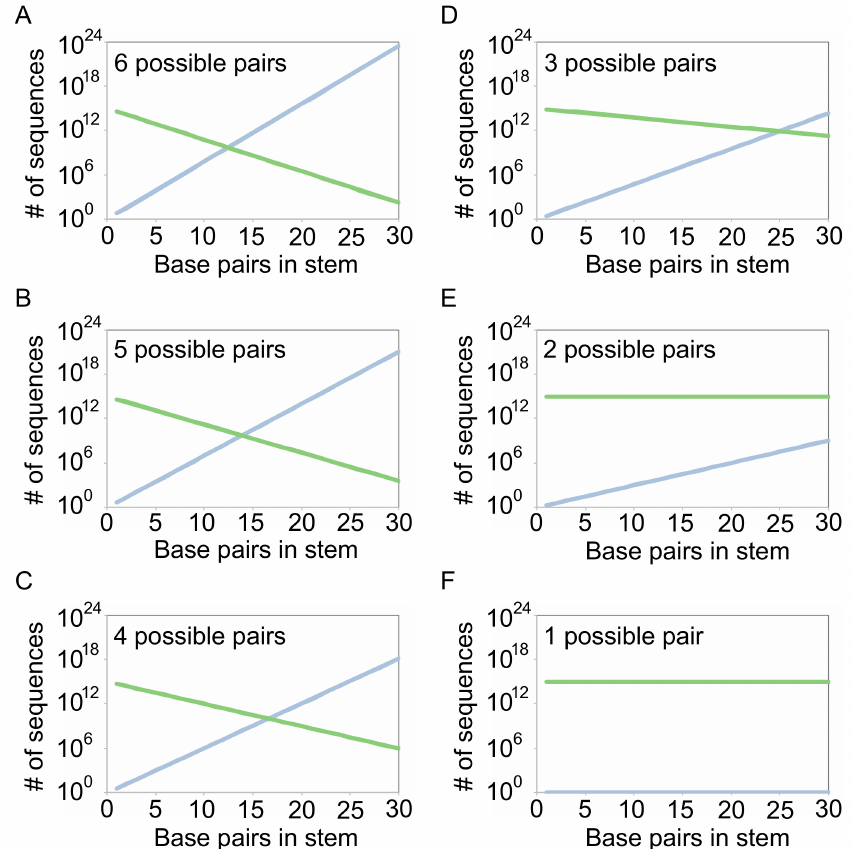
Figure 4. Maximizing the number of unique sequences that form a specific stem in libraries of 10 15 sequences. The graphs showing the relationship between the number of base pairs in a stem, the number of possible variants of the stem for the indicated coding scheme (blue curves), and the expected number of variants in a library of 10 15 sequences with the potential to form all of the pairs in the stem (green curves) for the indicated coding scheme. The number of unique variants in the library at each point on the x axis is indicated by the curve with the lower value, and the average copy number of library members is greater than one to the left of each intersection point and less than one to the right of each intersection point. ( A ) Coding scheme in which 6 pairs can occur. An example is N (A, C, G, or U) and N. The probability of forming a pair is 0.375. ( B ) Coding scheme in which 5 pairs can occur. An example is D (A, G, or U) and N (A, C, G, or U). The probability of forming a pair is 0.417. ( C ) Coding scheme in which 4 pairs can occur. An example is K (G or U) and N (A, C, G, or U). The probability of forming a pair is 0.5. ( D ) Coding scheme in which 3 pairs can occur. An example is R (A or G) and Y (C or U). The probability of forming a pair is 0.75. ( E ) Coding scheme in which 2 pairs can occur. An example is G and Y (C or U). The probability of forming a pair is 1. ( F ) Coding scheme in which 1 pair can occur. An example is G and C. The probability of forming a base pair is